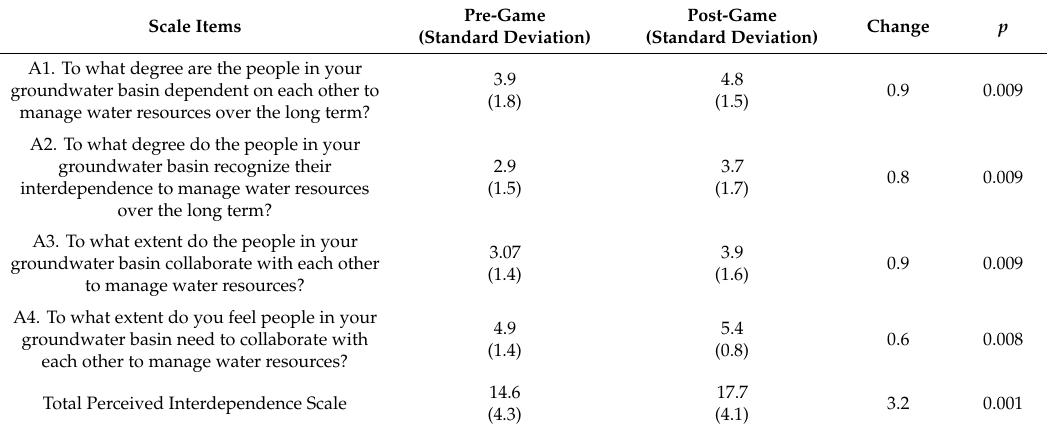
Table 2. Perceived Interdependence n = 40.